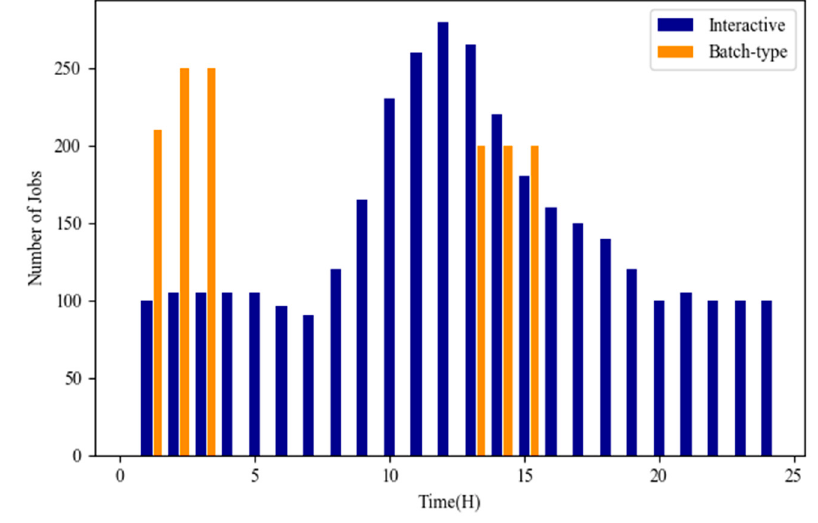
Table 1. Parameters Settings.